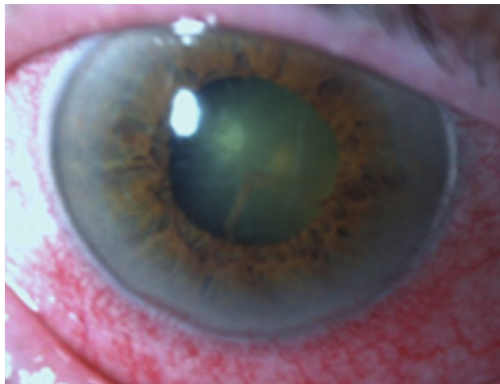
Figure 1: Corneal edema and a white hypopyon filling one-third of the anterior chamber.